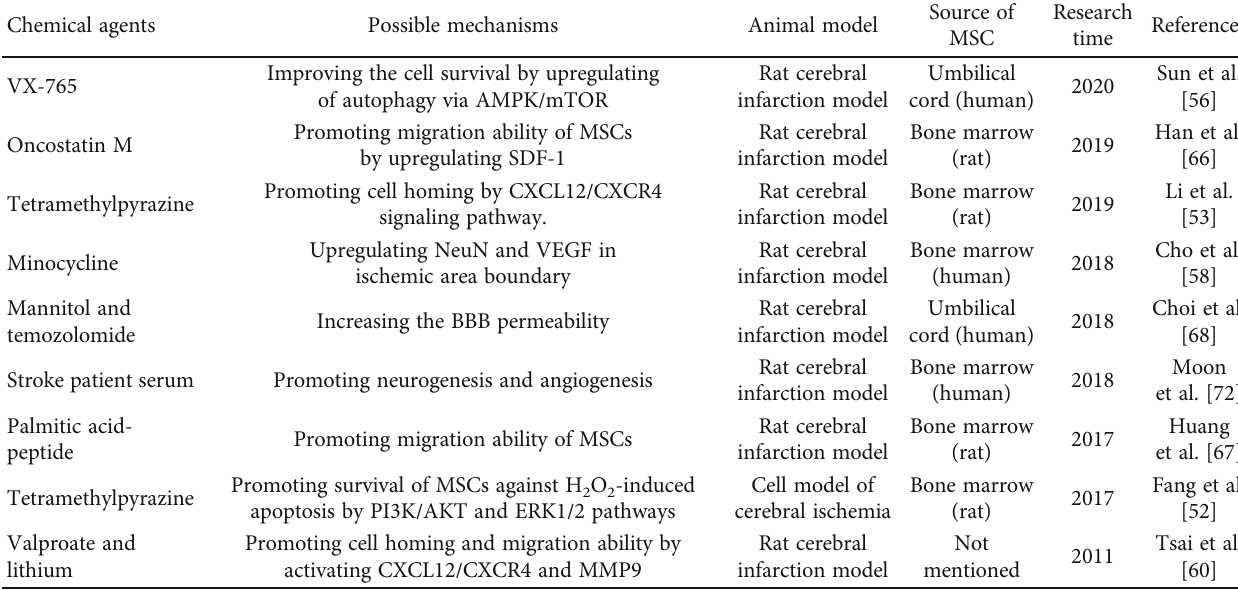
Table 2: Recent studies reporting chemical agents that can improve the e ffi ciency of MSC transplantation in ischemic stroke models. Chemical